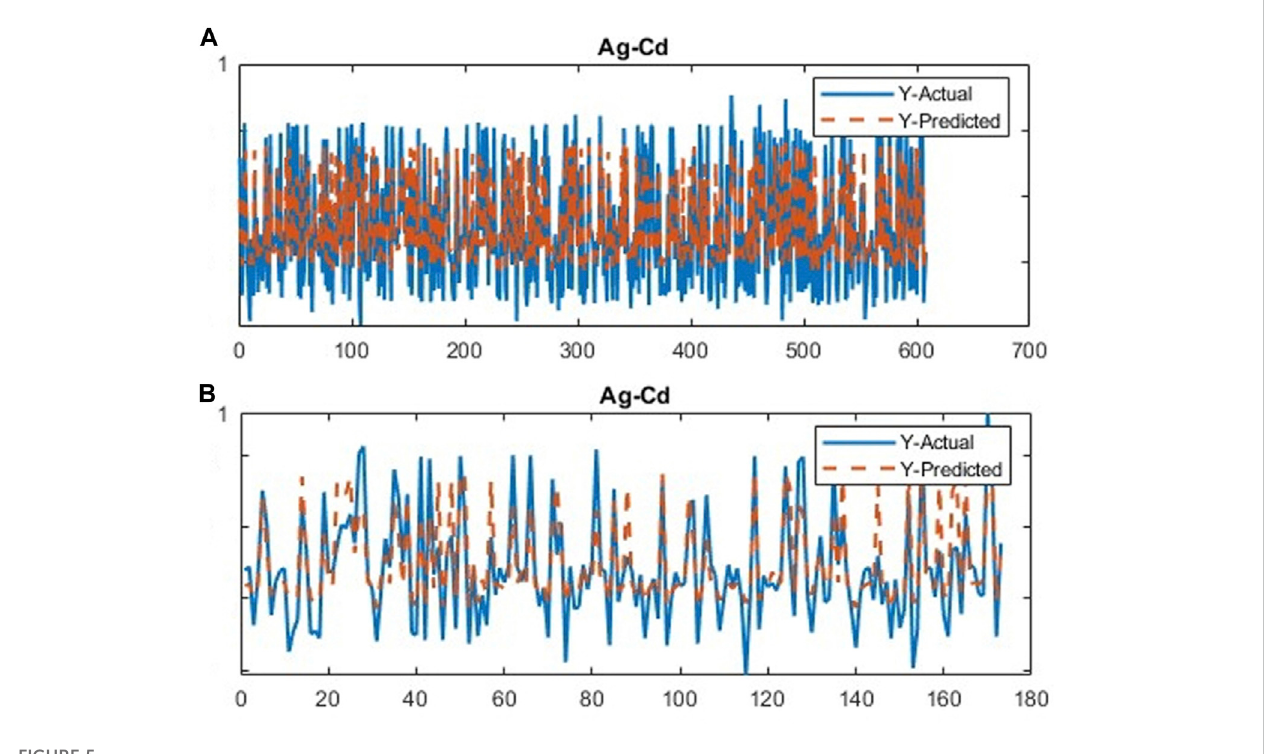
FIGURE 5 Plot of the running CDL network for the fi rst stage of clustering the second group of geochemical indicator elements (Ag – Cd); (A) training data and (B) testing data.